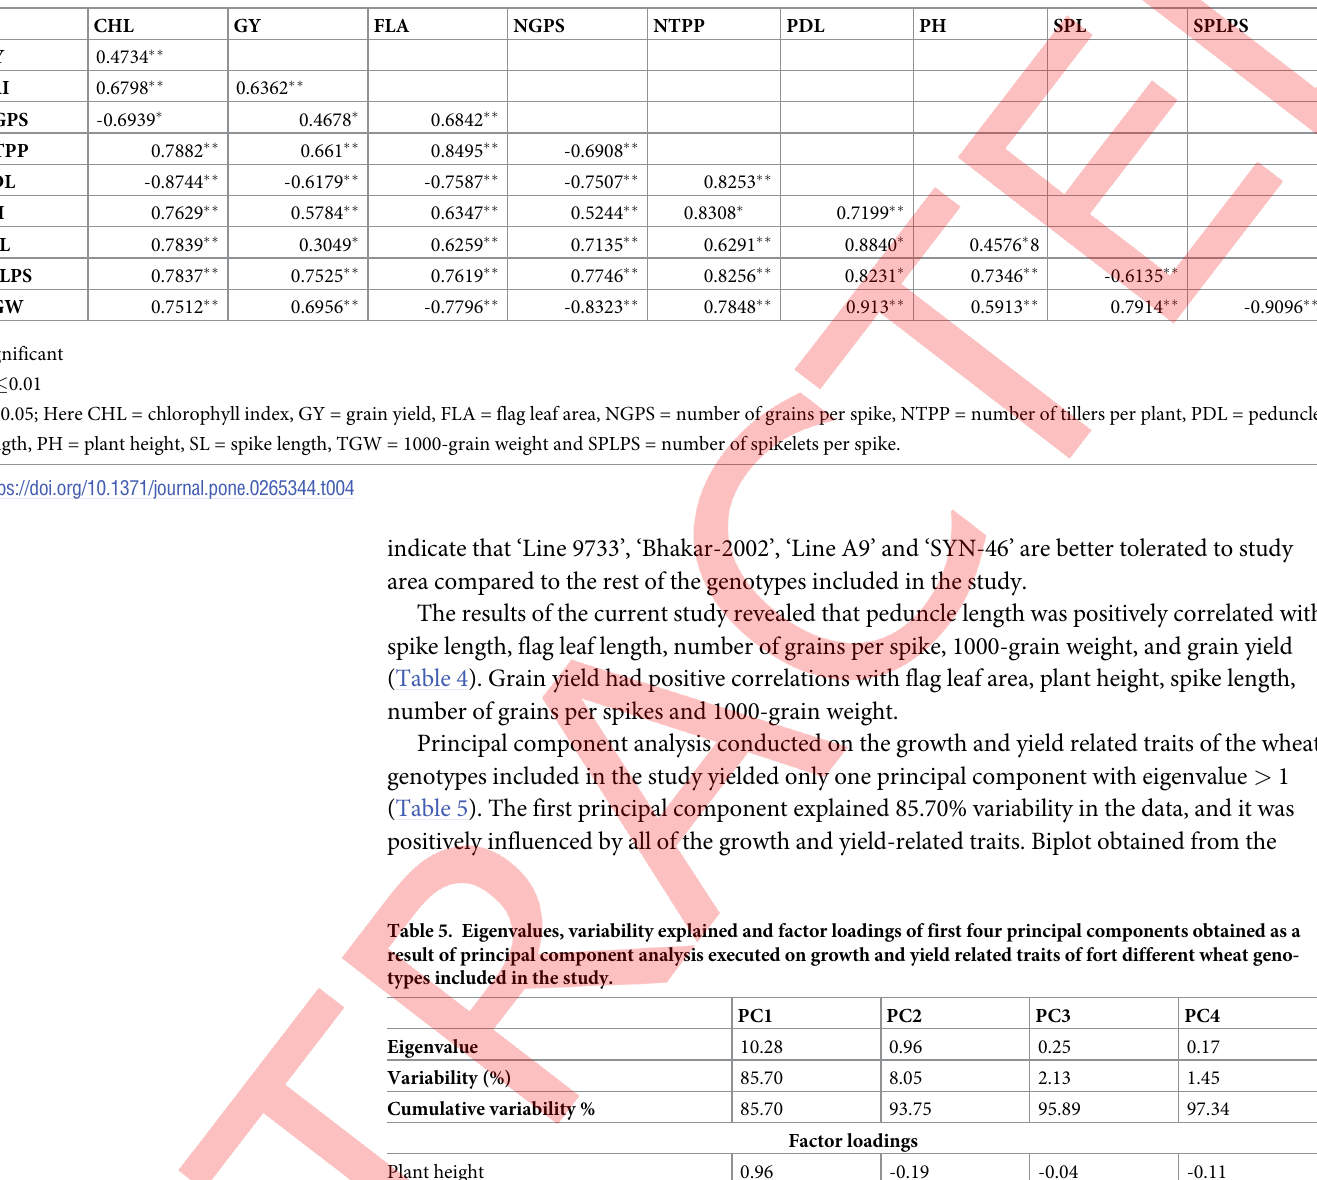
Table 4. Correlation matrix for different morphophysiological traits of different wheat genotypes used in the study. CHL GY